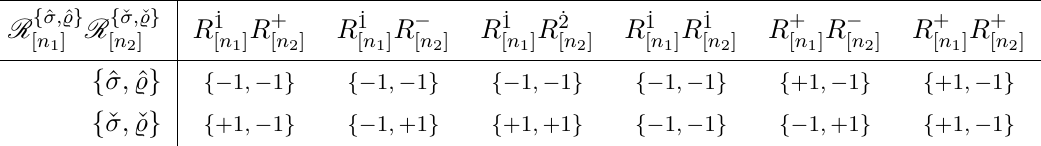
R { ˇ σ, ˇ % } to the Ramond ground [ n 1 ] [ n 2 ]